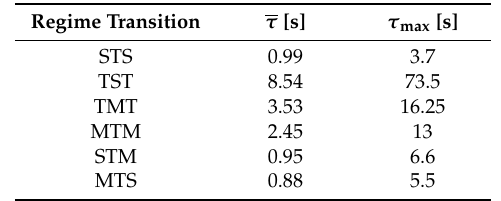
Figure 4. Regime transition frequency as a function of the retention time 𝜏 . Regime transition classifications are indicated in the left corner of each panel. The second capital letter always indicates the area, in which the retention time 𝜏 was measured. The regime transition count for each retention time was scaled logarithmically. Table 1. Average and maximal retention time in a specific regime. For the six regimes (STS, TST, TMT, MTM, STM, and MTS), the average ( 𝜏 ̅ ) and maximal retention times ( 𝜏 max ) are displayed in seconds. The maximum 𝜏 was defined as the limit, within which 99% of the values were located.